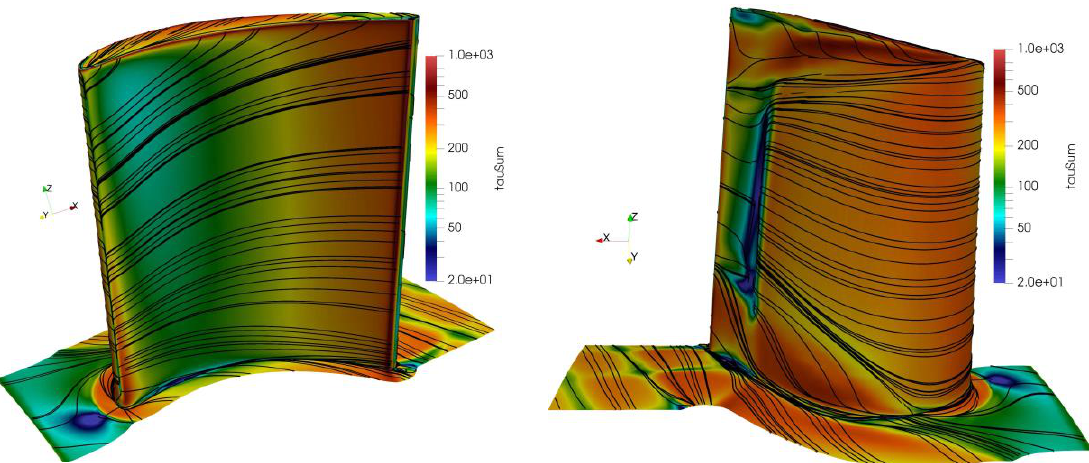
Figure 8. Contours of streamwise vorticity in the tip region.